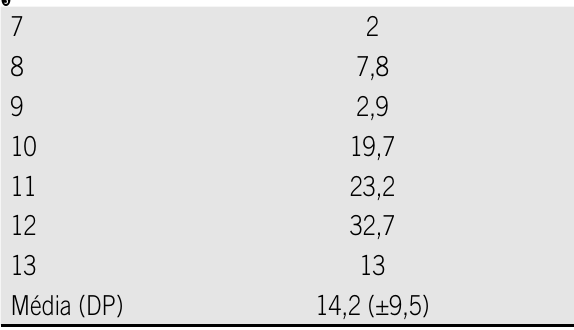
Figura 3 . O teste de Kolmogorov Smirnov revelou que os dados apresentavam uma distribuição normal (0,16 e 0,17). Porém, devido à grande variação dos dados, com o desvio padrão muito próximo da média (14,3 para o grupo HPV-positivo e 9,5 para o grupo HPV-negativo), optou-se por utilizar o teste não-paramétrico de Mann-Whitney, cujo resultado indicou não haver diferença estatisticamente significativa entre os dois grupos ( p =